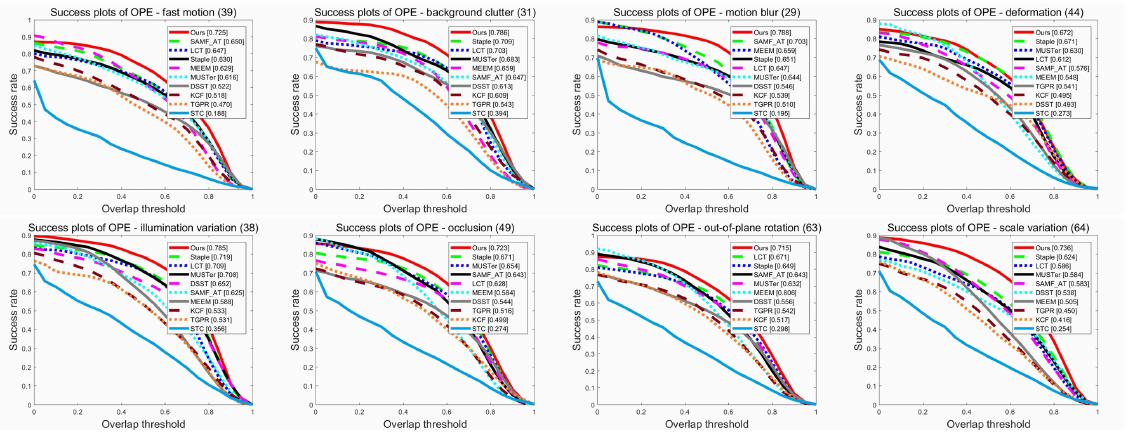
Figure 5. Performance evaluation of overlap precision on eight challenging attributes (FM, BC, MB, DEF, IV, OCC, OPR and SV) of the OTB-2015